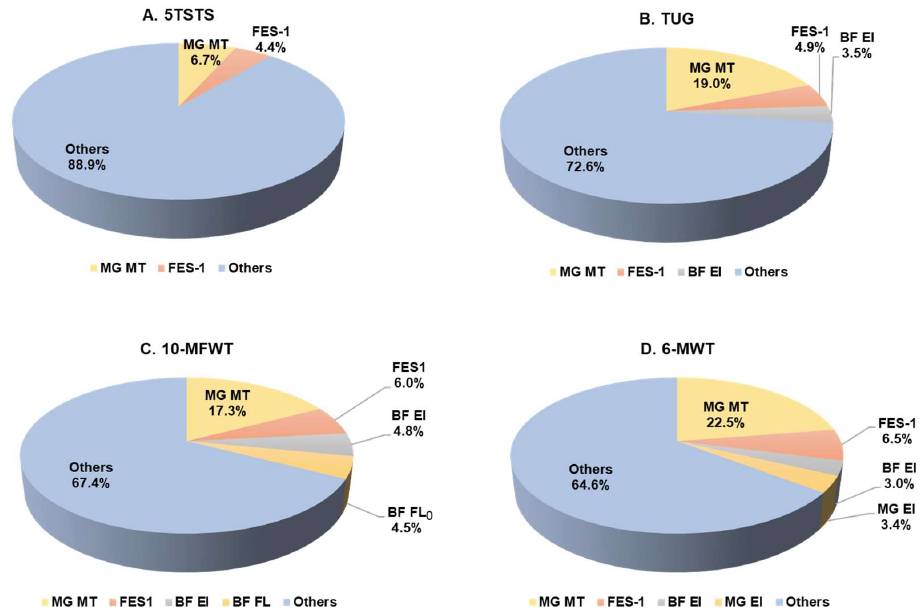
Figure 1. The percentages of explained variance for functional performance variables. ( A ) 5TSTS performance, ( B ) TUG performance, ( C ) 10-MFWT performance, ( D ) 6-MWT performance. MT, muscle thickness; BF, biceps femoris; MG, medial gastrocnemius; FL 0 , resting fascicle length; FES-1, Falls Efficacy Scale-international; 5TSTS, five times sit to stand; TUG, timed up and go; 10-MFWT, 10 min fast walk test; 6-MWT, six minutes walk test.